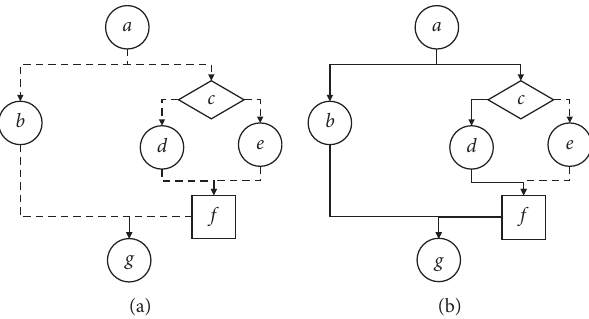
Figure 2: (a) AND/OR network and (b) the shortest path from a to g (solid